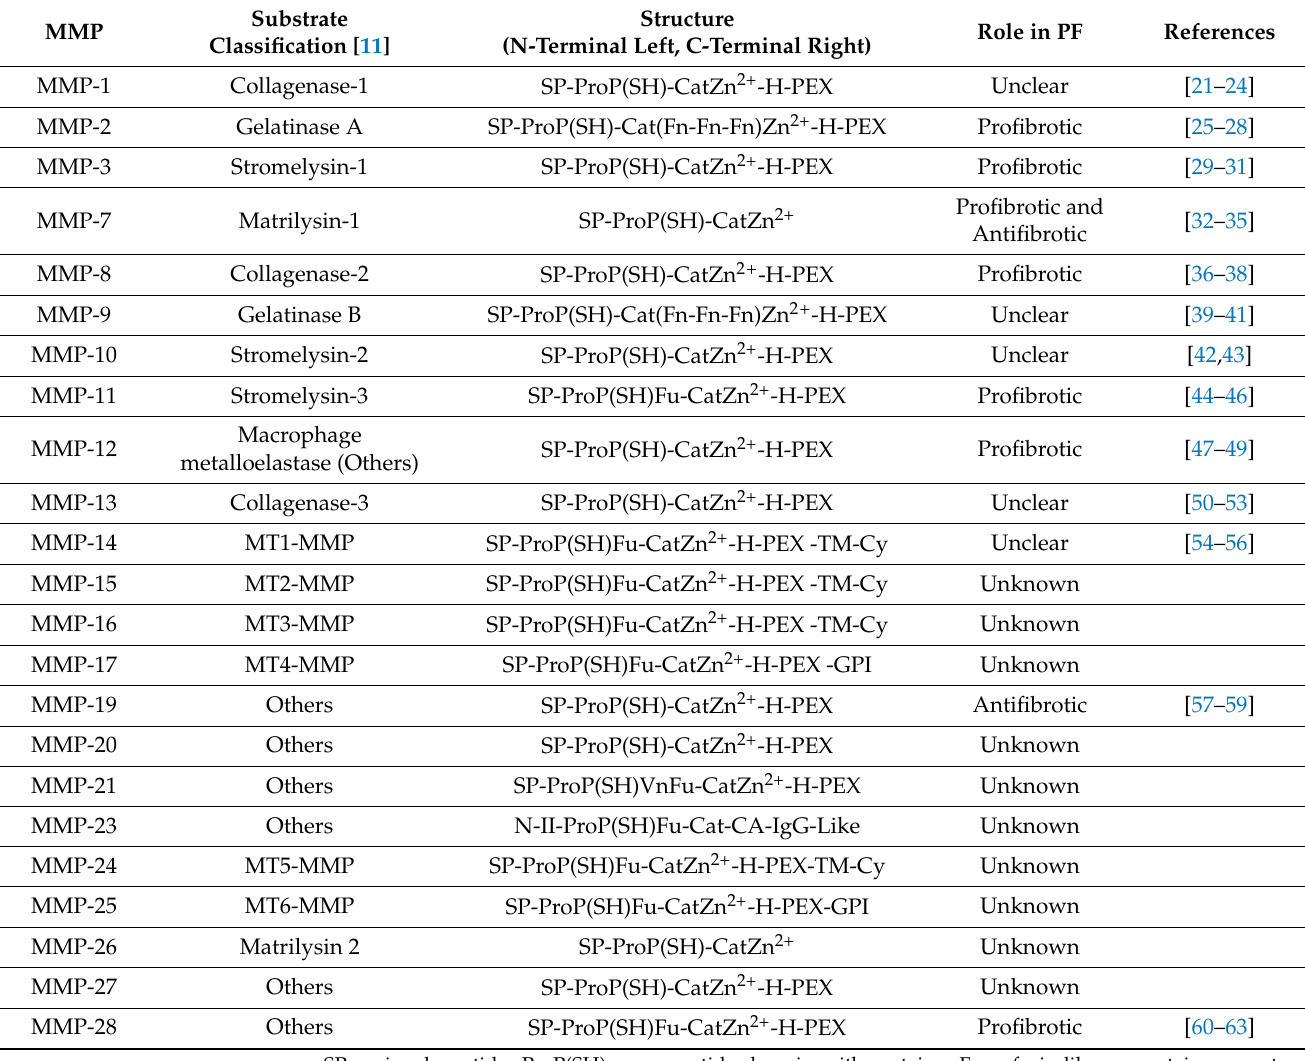
Table 1. Classification of matrix metalloproteinases and their role in pulmonary